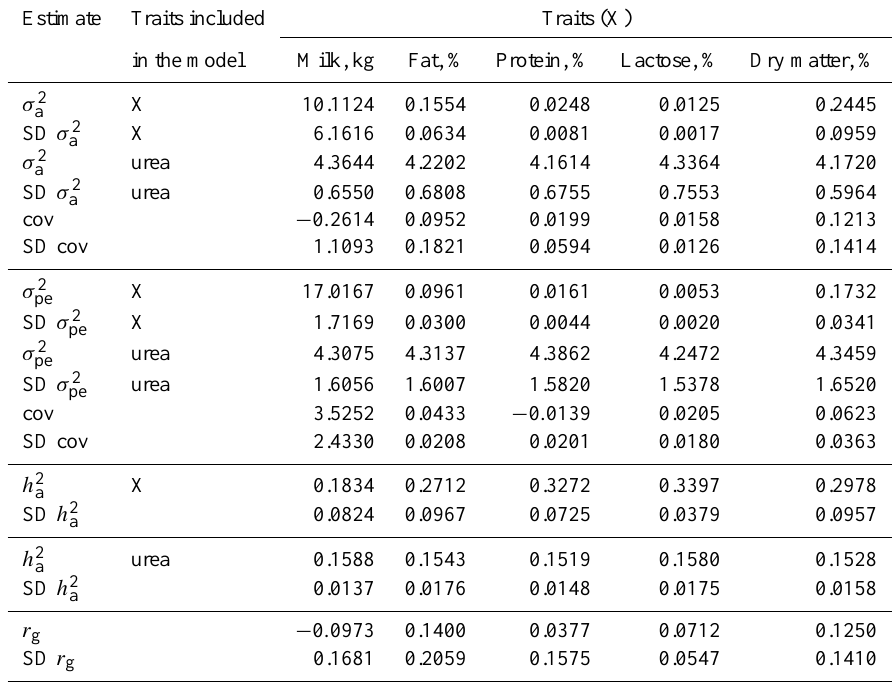
Table 4. Estimates of (co)variance components, heritability and repeatability of milk yield, milk composition calculated based on the bivariate linear–linear models.